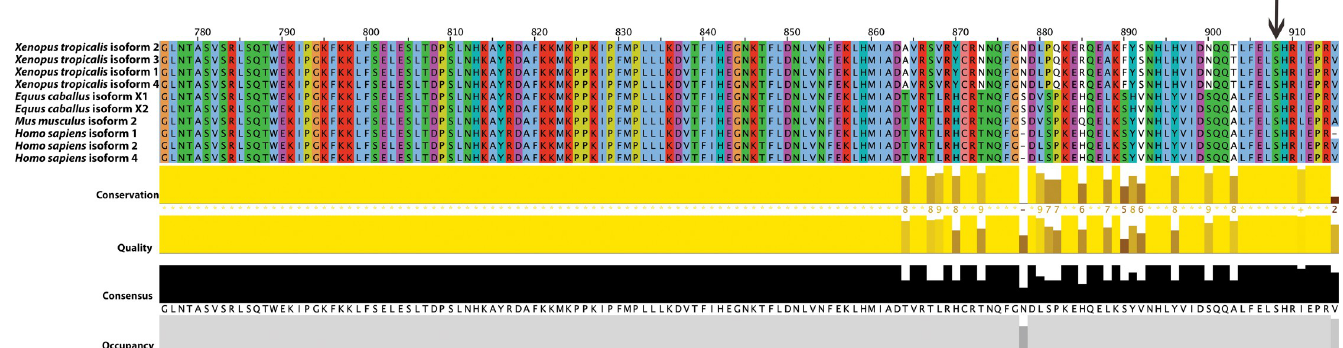
Fig 3. Alignment of protein sequences between Xenopus tropicalis , Equus caballus , Mus musculus and Homo sapiens . RAPGEF5 protein sequences from the two predicted equine NCBI proteins (isoform X1 = XP_023495120.1 and isoform X2 = XP_023495121.1), three human RefSeq proteins that extended to the 3’ end of the equine annotated protein (NP_036426.4 = isoform 1, NP_001354529 = isoform 2 and NP_001354531.1 = isoform 4), the only mouse RefSeq protein (NP_787126.3 = isoform 2) and four predicted Xenopus tropicalis (isoform 2 = XP_031759510.1, isoform 1 = XP_031759509.1, isoform 3 = XP_017950421.2 and isoform 4 = XP_031759511.1) proteins were aligned, demonstrating strong conservation even within alternate isoforms of RAPGEF5. The serine residue that is altered with RAPGEF 5 c.2624C > A,p.Ser875 � is highlighted with a black arrow toward the end of the sequence